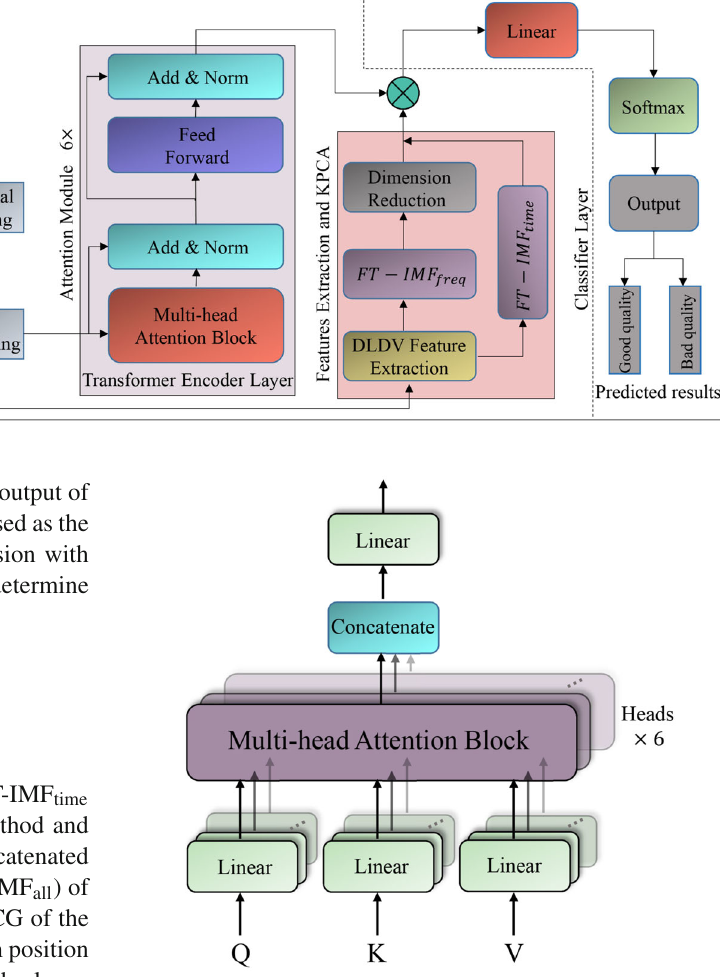
Fig. 5 The overall structure of the proposed DI-Transformer model